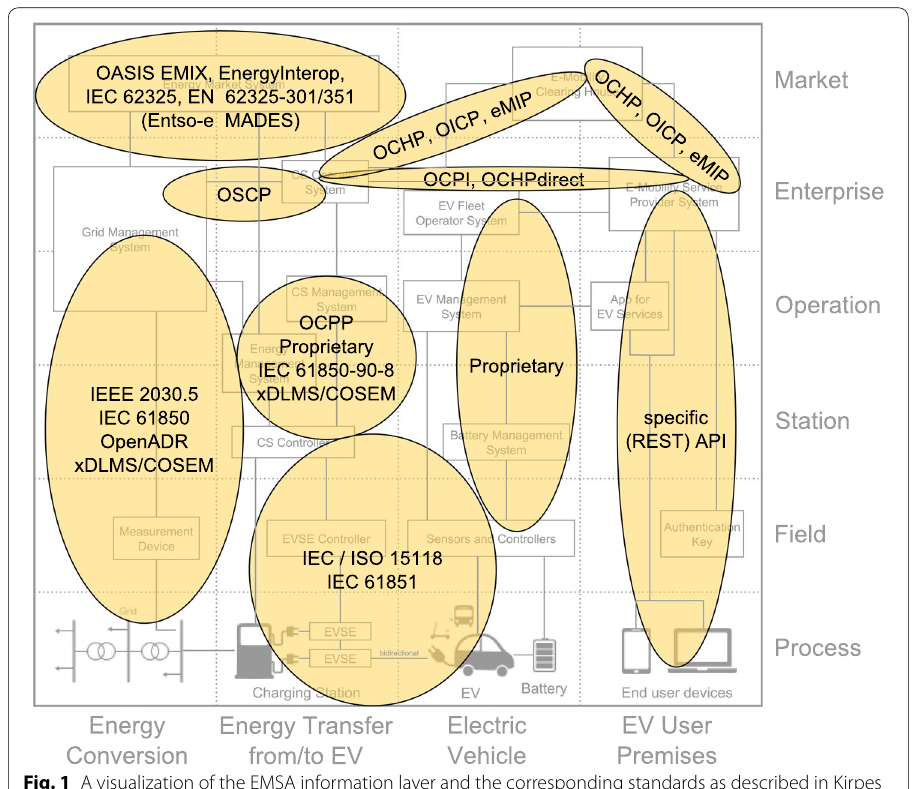
Fig. 1 A visualization of the EMSA information layer and the corresponding standards as described in Kirpes et al. (2019): The horizontal axis denotes the zones, and the vertical axis denotes the domains. The squares in the background represent the actors, systems and devices of the EV ecosystem, and the yellow circles represent the standards used by the encompassed actors, systems and